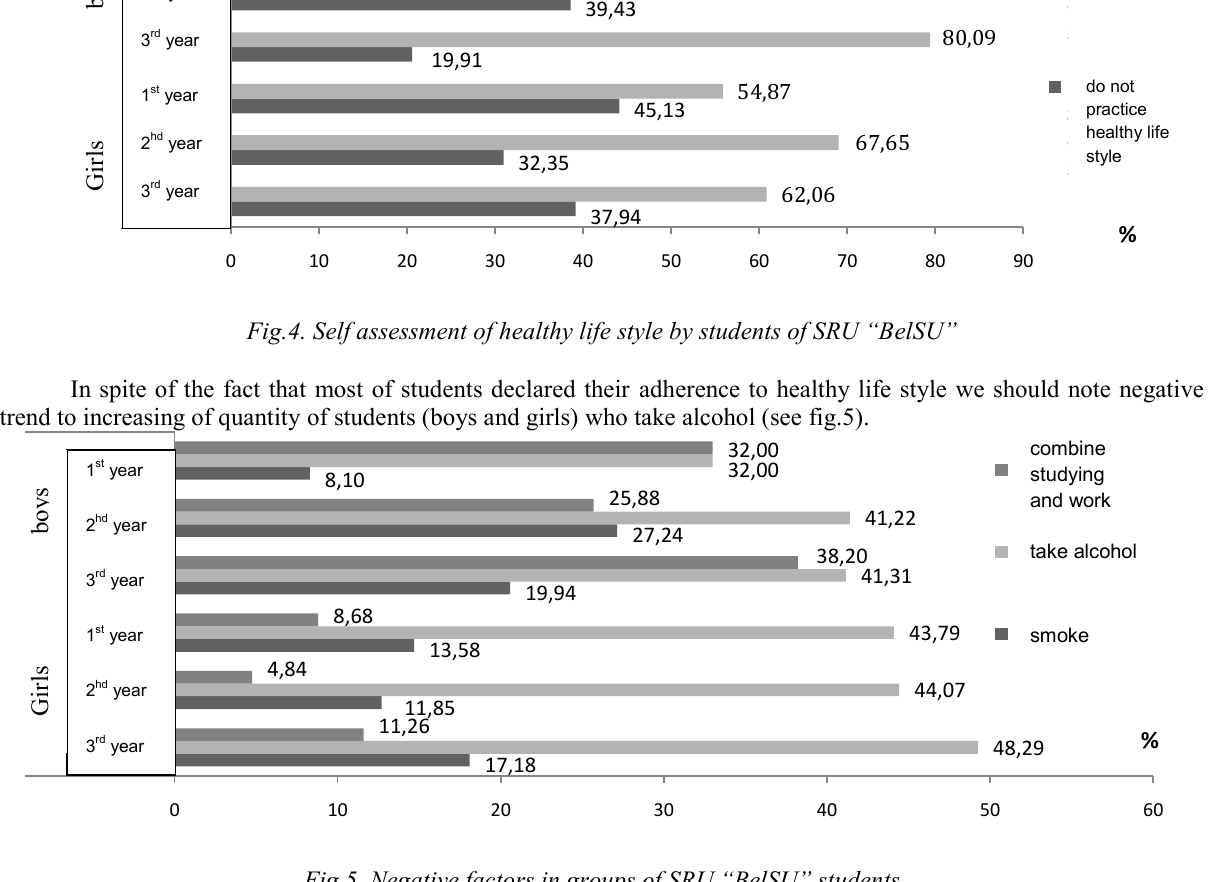
Fig.5. Negative factors in groups of SRU “BelSU”